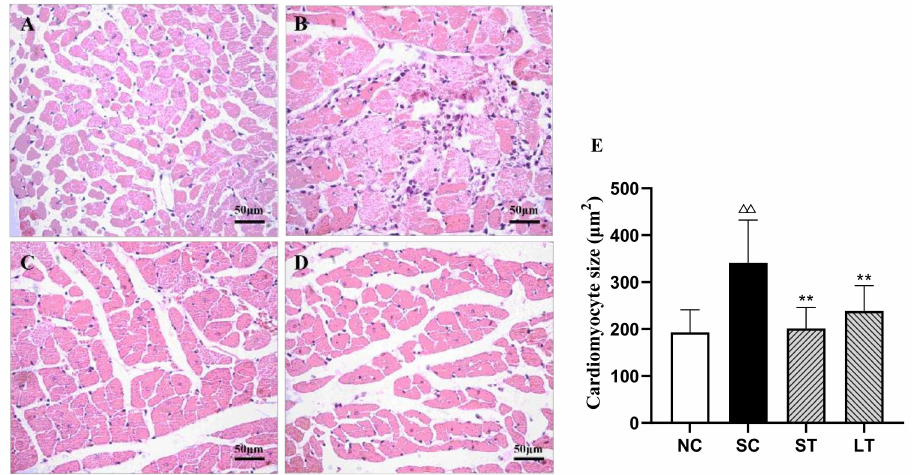
Figure 2. Cardiomyocyte. NC group ( A ), SC group ( B ), ST group ( C ), LT group ( D ), and size of cardiomyocytes ( E ). Data were expressed as the mean ± SD ( n = 8 rats/group). ∆∆ p < 0.01 compared with NC; ** p < 0.01 compared with SC.